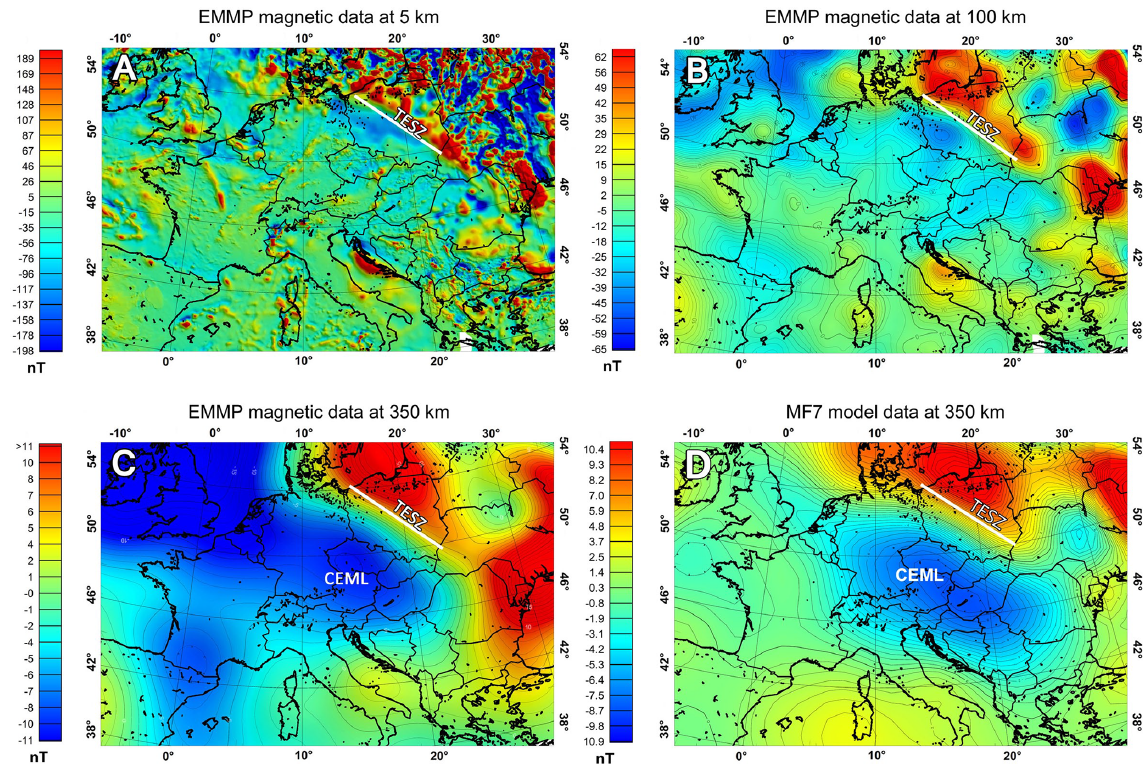
Figure 4. Aeromagnetic field map of Europe at 5km (a) , 100km (b) and 350km of altitude (c) ; map of MF7 magnetic field model at 350km of altitude (d)